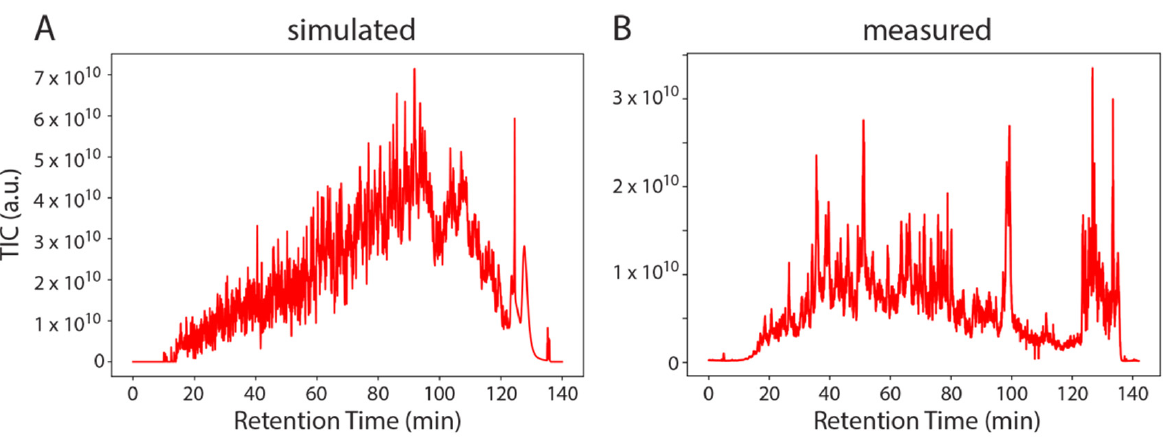
Figure 4. Example of SMITER output. Two total ion chromatograms (TIC): simulated ( A ) and measured ( B ) from a complex mix of yeast peptides. Intensity is plotted on the y-axis (a.u.) over the retention time (min).